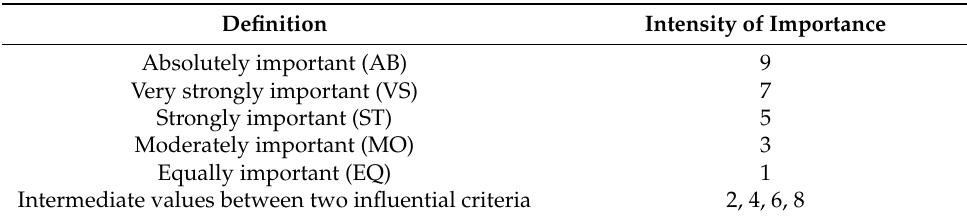
Table 1. Influential criteria in linguistic terms for priority